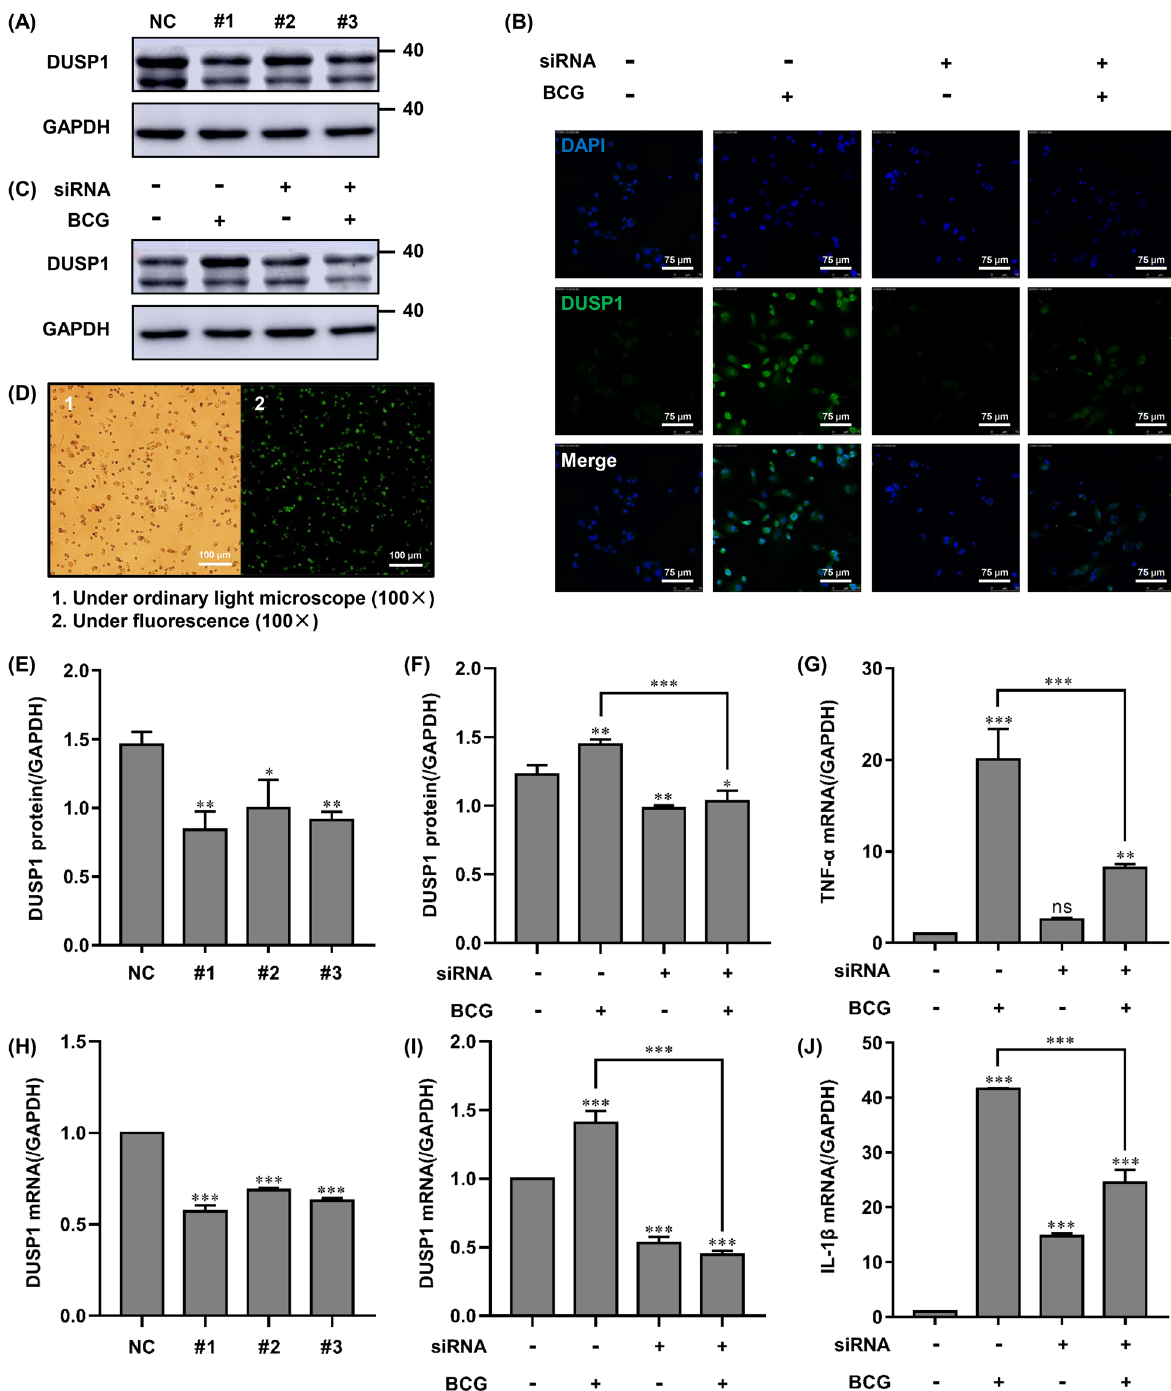
Figure 2. Effect of DUSP1 knockdown on DUSP1, TNF-α and IL-1β in BCG-induced THP-1 cells. ( A , E , H ) THP-1 cells were transfected with three different targeting siRNA-DUSP1 for 24 h, and knockdown was verified by Western blotting and RT-qPCR. ( B , C , F , I ) THP-1 cells were transfected with siRNA-NC (negative control) or siRNA-DUSP1 for 24 h and then infected with BCG for 6 h, and the knockdown effect was verified by immunofluorescence, Western blotting and RT-qPCR to verify the effect of DUSP1 knockdown. Scale bar, 75 μm. ( D ) Observation of siRNA-DUSP1 transfection efficiency by fluorescence microscopy. Scale bar, 150 μm. ( G , J ) THP-1 cells were transfected with siRNA-NC (negative control) or siRNA-DUSP1 for 24 h and then infected with BCG for 6 h. Expression of TNF-α and IL-1β was detected by RT-qPCR. All data are represented as mean ± SD (n = 3). (* p < 0.05, ** p < 0.01, *** p <